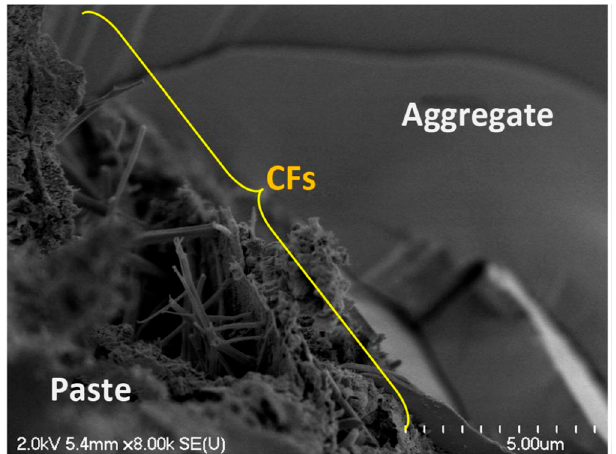
Figure 10. SEM image of the interfacial transition zone (ITZ) in self ‐ consolidating concrete (SCC) with 0.15% CFs. Reproduced from [21], with permission from American Society of Civil Engineers, 2018.